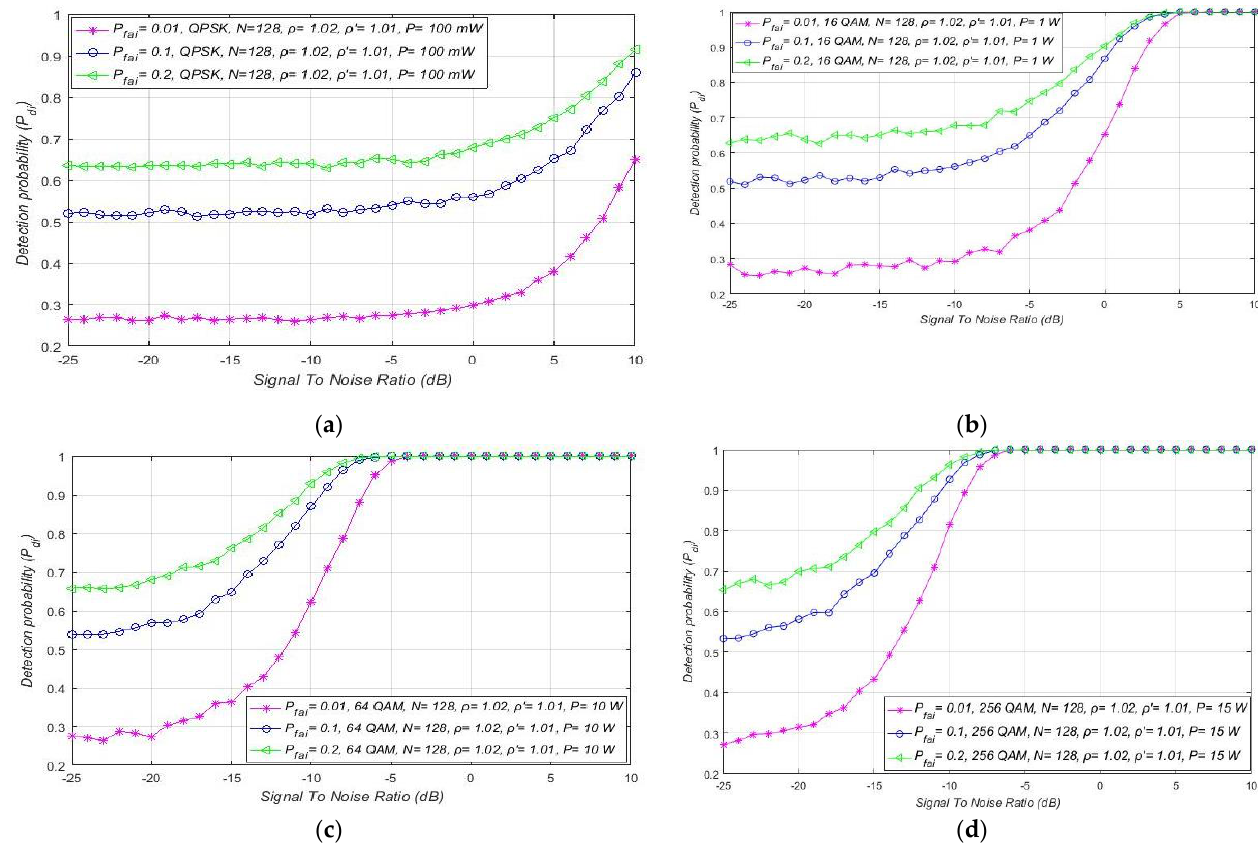
Figure 17. Detection probability vs. SNR relationship for distinct false alarm probabilities in combined MA and RA systems with PU transmitting at: ( a ) 0.1 W; ( b ) 1 W; ( c ) 10 W and ( d ) 15 W.